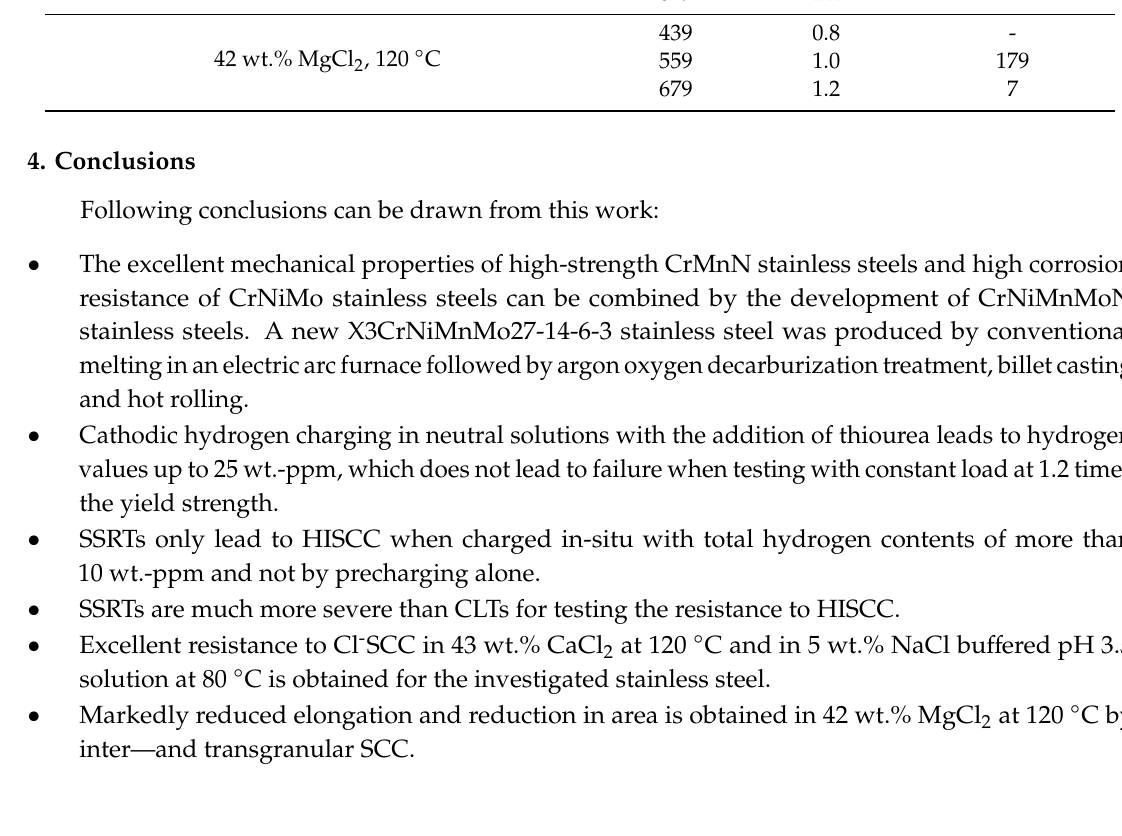
in area and visible stress corrosion cracking, ( b ) mainly intergranular stress corrosion cracking at the edge